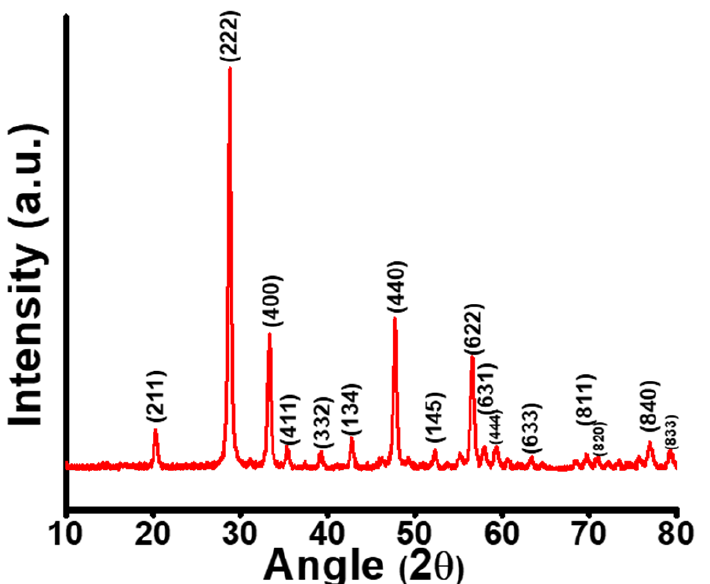
Figure 1. X-ray diffraction pattern of Gd 2 O 3 NPs.